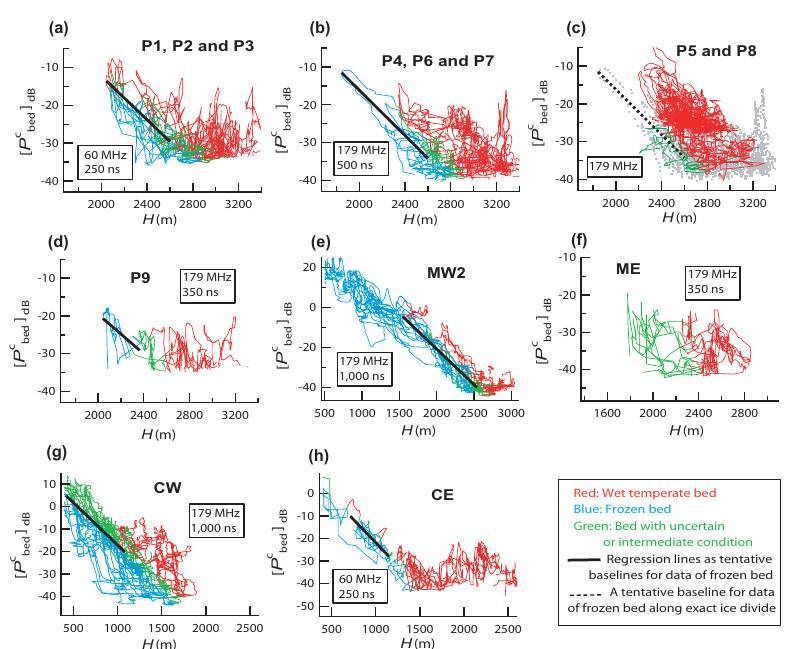
Fig. 9. The graphs of the H-P plot are expressed as trajectories of the data from one location to another. The predicted bed condition, i.e. temperate bed, frozen bed, or uncertain condition, is given. The ID of the leg(s) and the radar settings are indicated on each panel. The red, blue, and green traces indicate temperate bed, frozen bed, and uncertain conditions, respectively. See text for details.